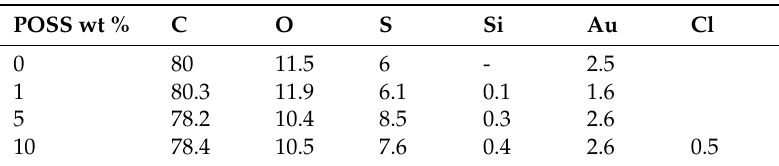
Table 1. EDX analysis of PES–POSS fibres (atomic percentage calculated by selecting seven areas per sample and three points per area in each sample).